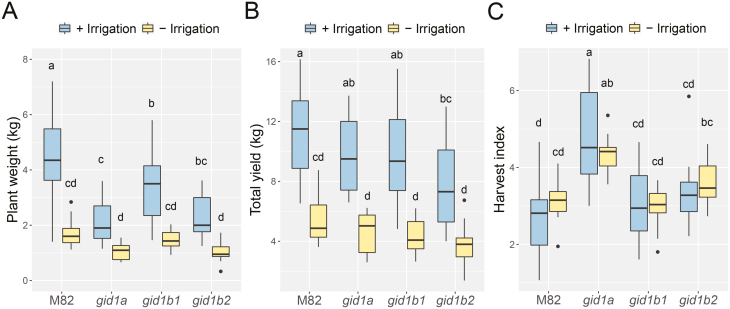

gid1a plants exhibit high harvest index in the field under irrigation and drought conditions. M82 and all single gid1 mutants were planted in the field. Plants from each line were planted randomly and were irrigated normally throughout the experiment. Half of the plants of each line were irrigated normally for 3 weeks and then irrigation was stopped until harvesting (approximately three more months). (A) Plant vegetative fresh weight (after removal of all fruits) at harvest. (B) Total fruit yield (green and red fruits). (C) Harvest index (total yield to vegetative fresh weight). Data in (A–C) (taken from 15 different plants) are graphically presented as box and whisker plots. Lowercase letters represent significant differences between respective treatment and lines (Tukey–Kramer HSD, P<0.05).